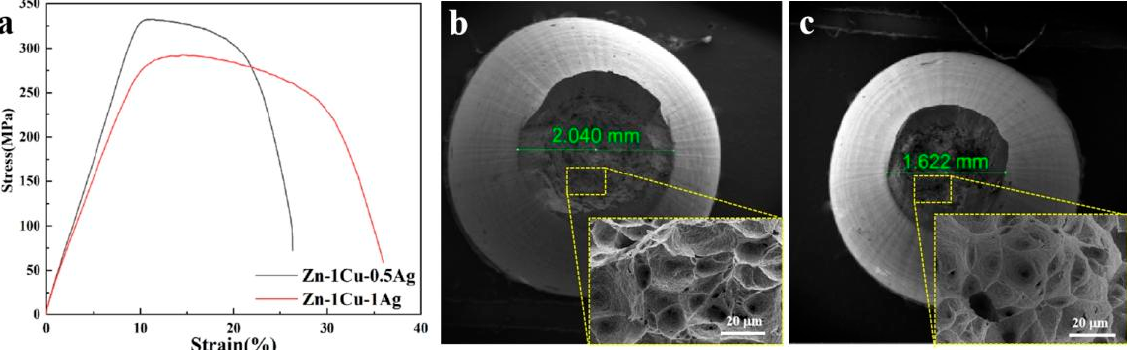
Figure 3. ( a ) Stress–strain curves for alloy, the SEM images of fracture morphologies of ( b ) the Zn-1Cu-0.5Ag alloy and ( c ) the Zn-1Cu-1Ag alloy. Table 2. Hardness values and tensile properties of the Zn-1Cu-xAg alloys. Materials Hardness (HV) UTS Zn-1Cu-0.5Ag